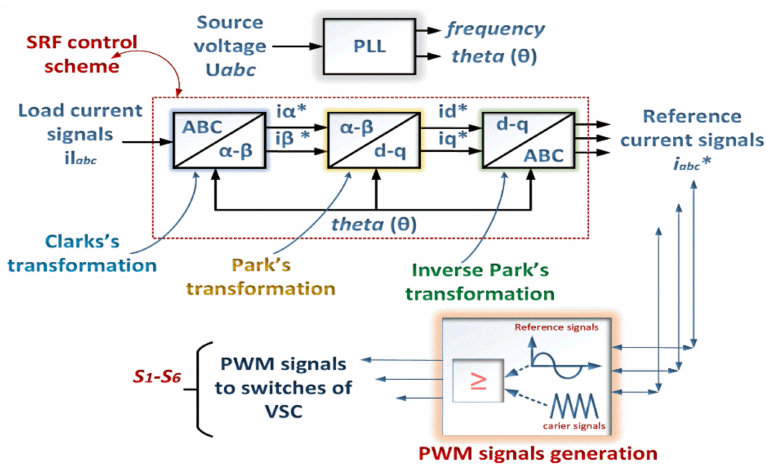
Figure 4. Synchronous Reference Frame (SRF) control